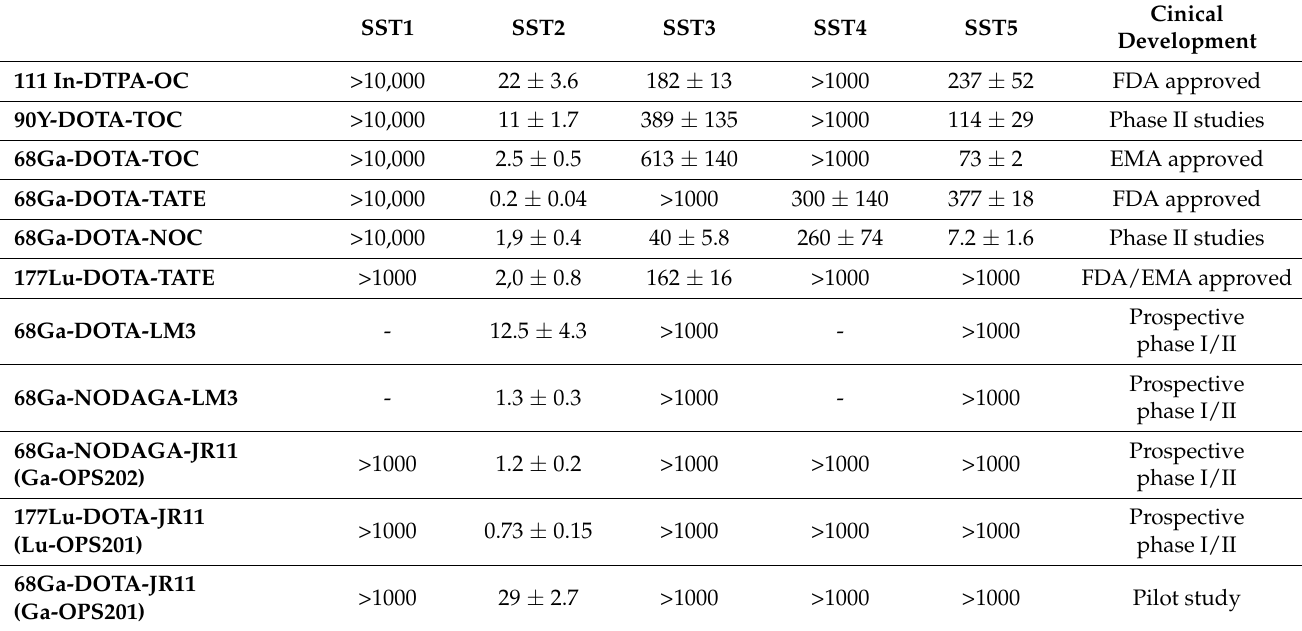
Table 5. Ligand-binding affinities according to in vitro assays from somatostatin-based radiochemi- cals (50% inhibitory concentration (IC50) in nM ± standard error of the mean) with clinical data. SST1 SST2 SST3 SST4 SST5